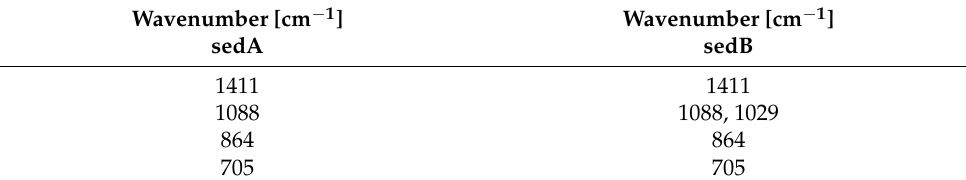
Table 3. Summary of the wavelengths in the FTIR analysis of bottom sediment samples.